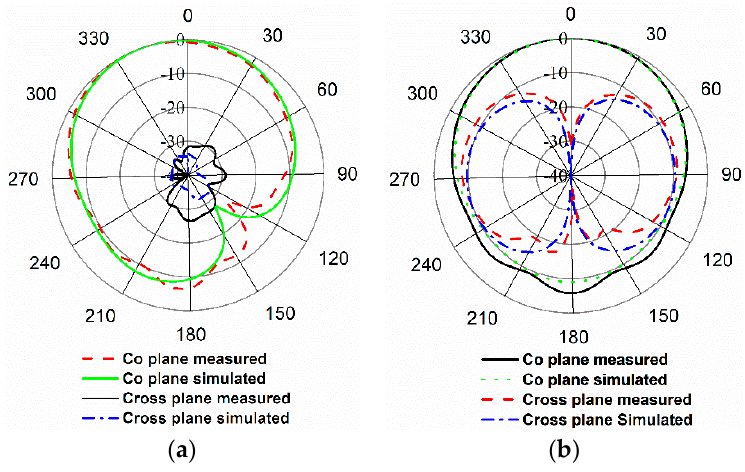
Figure 6. Simulated and measured radiation patterns at 1.63 GHz for ( a ) phi = 0° and ( b ) phi = 90°.